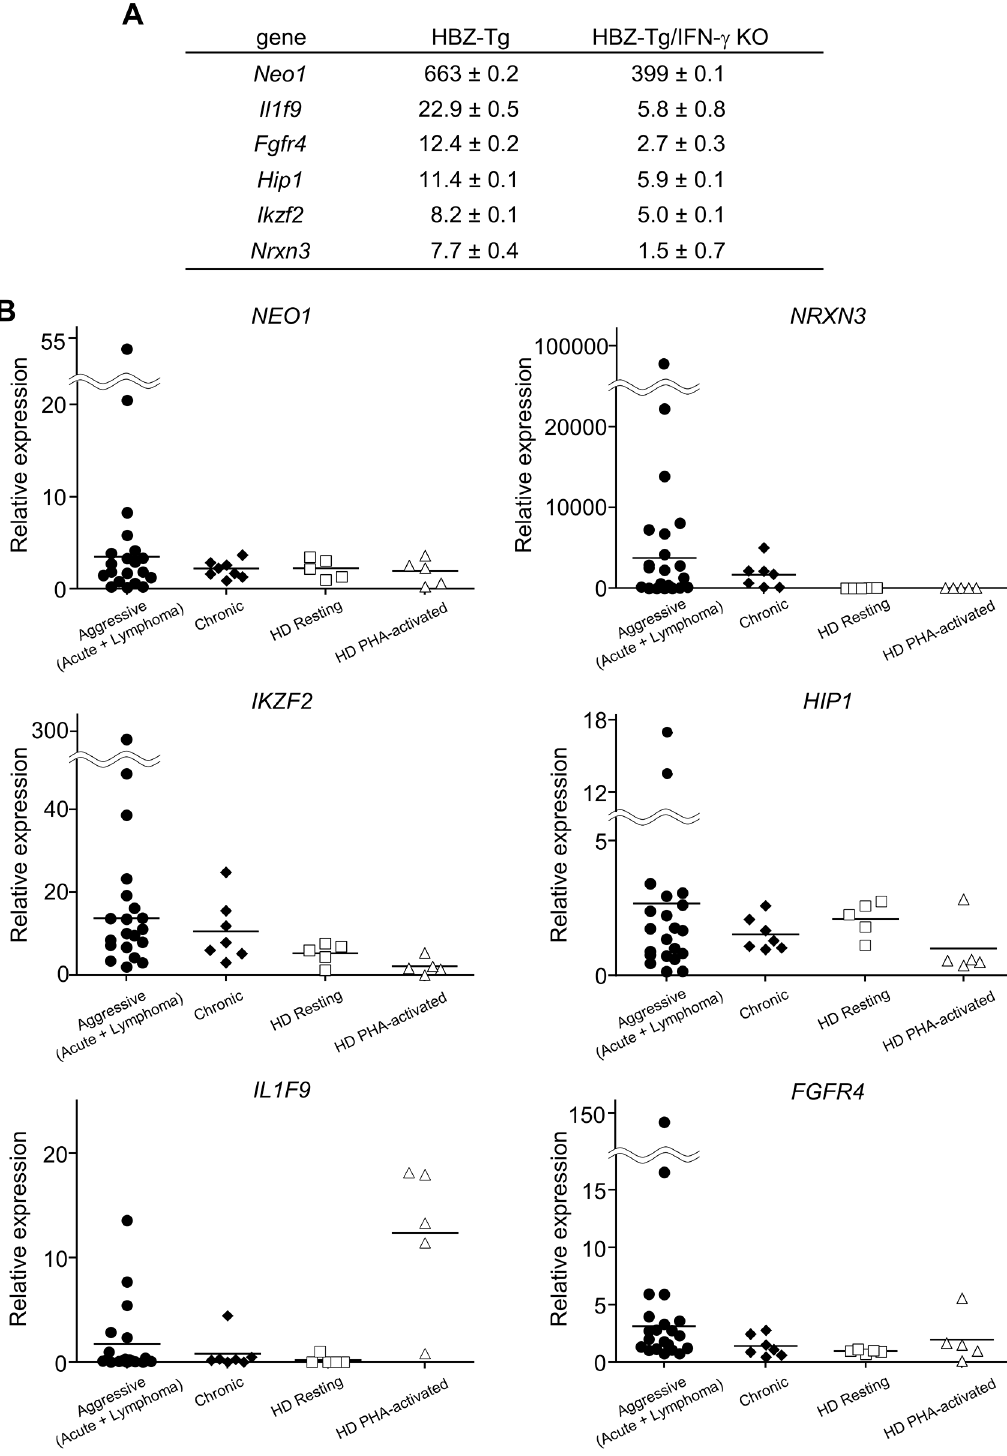
Fig 7. Microarray analysis of WT, HBZ-Tg, IFN- γ KO, and HBZ-Tg/IFN- γ KO mice. CD4 + T cells were purified from splenocytes of WT, HBZ-Tg, IFN- γ KO, and HBZ-Tg/IFN- γ KO mice. (A) Validation of the microarray result by qPCR. cDNA of splenocytes from WT, HBZ-Tg, and HBZ-Tg/IFN- γ KO mice were used. Expression levels of the candidate genes were normalized using the values of WT as reference. (B) Transcription levels of the human homologues of the candidate genes in ATL patients and healthy donors (HD). Relative expression values were calculated by the delta delta Ct method using a value of one resting sample as reference. Aggressive: acute and lymphoma types of